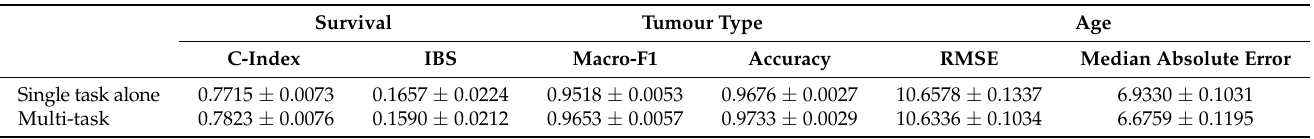
Table 8. Multi-task training performance of OmiEmbed with three typical downstream tasks. For C-index, macro-F1 and accuracy, higher values mean better prediction performance. For IBS score, RMSE and median absolute error, lower values mean better prediction